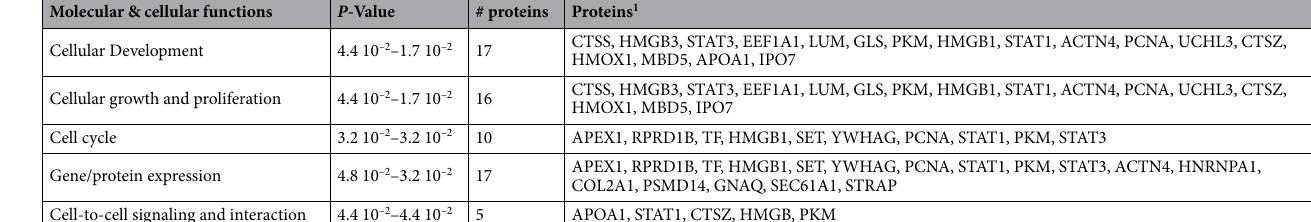
Table 6. Top molecular and cellular functions for DE proteins in broiler tibiae with BCO. 1 ACTN4, Actinin